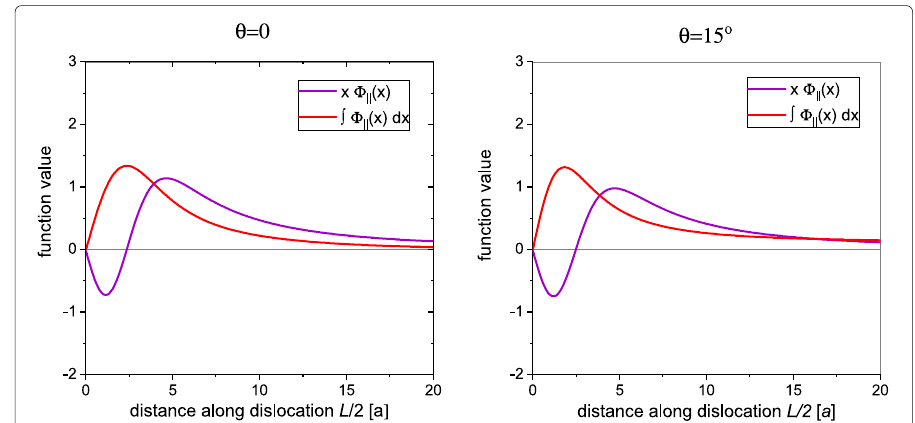
Fig. 4 Determination of the pinning length for screw-like pinning from Eq. (24) for a pure screw (left) and a 15deg dislocation (right). Note that Eq. (24) is not valid for the edge-like branch of pinning energy maxima which exhibits much higher pinning